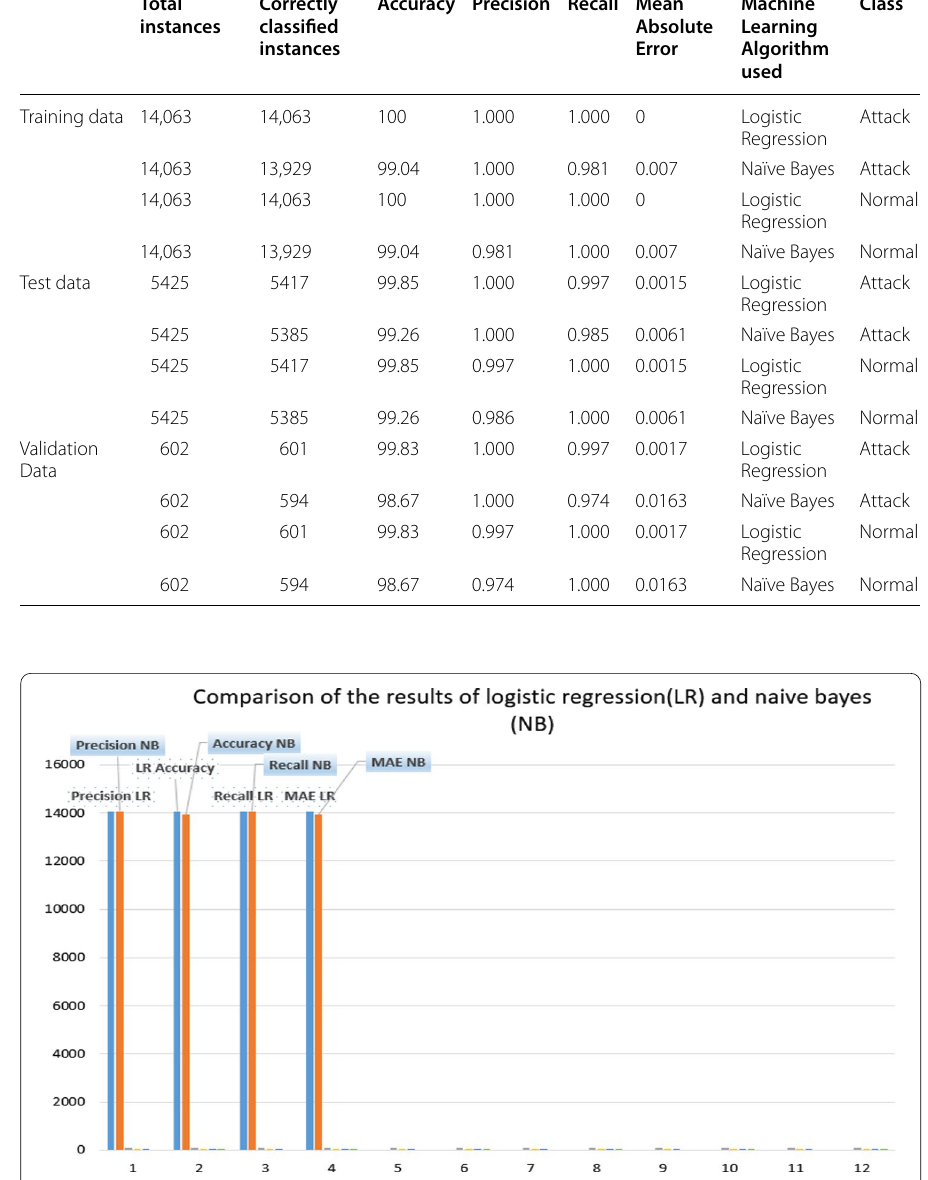
Fig. 9 Graphical comparison of the logistic regression and naive bayes